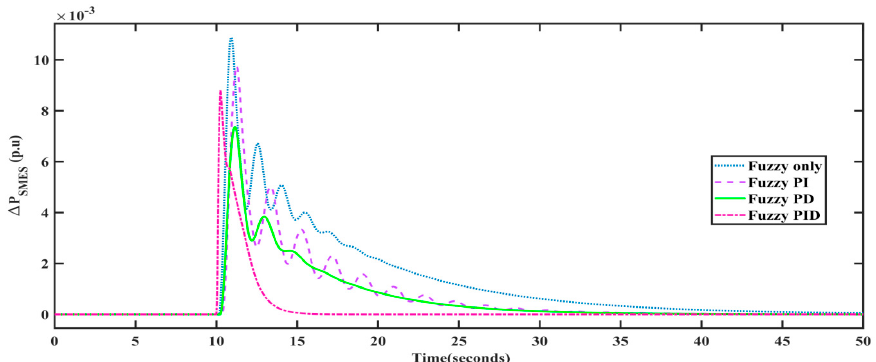
Figure 13. Dynamic response comparison of different control configurations of IHPS SMES power variation with step input of 1% increase in load. Table 2. Settling time (seconds) for change in frequency and change in power of the hybrid system